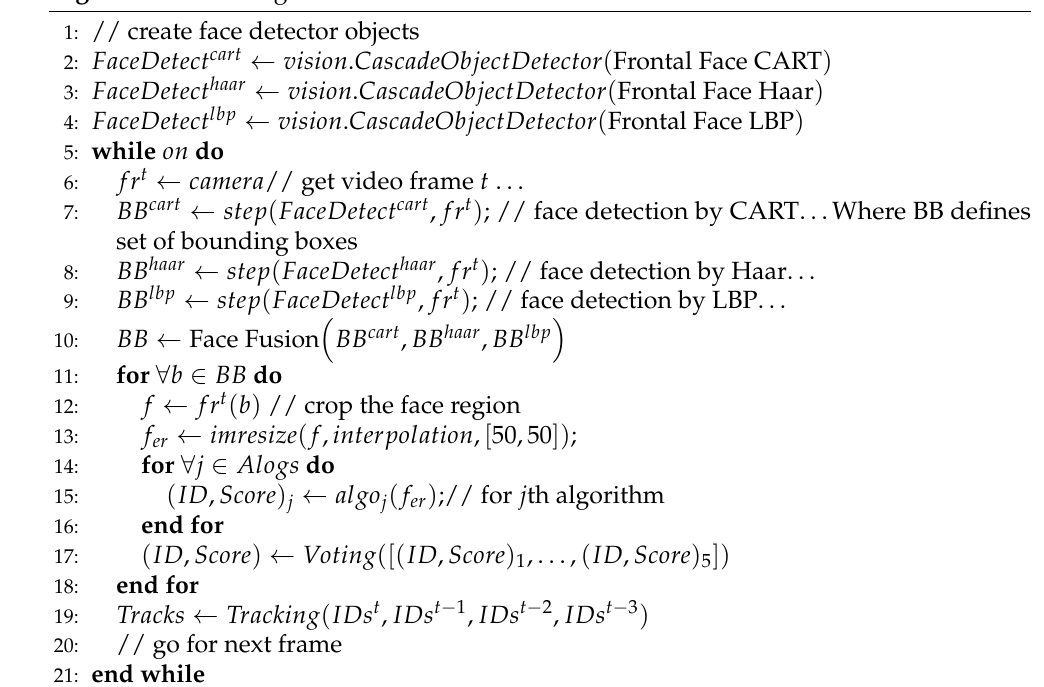
Algorithm 2 Tracking